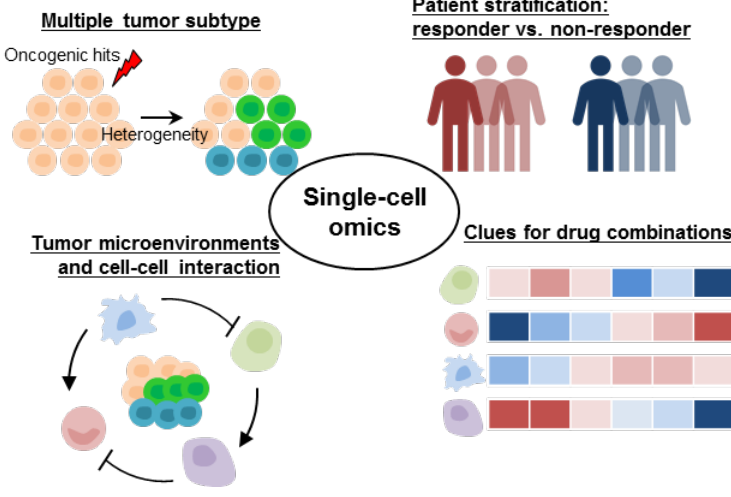
Figure 2. Gene expression heterogeneity in cancer addressed by scRNA-seq. Table 2. Single-cell studies dissecting tumor signatures and specific microenvironment.